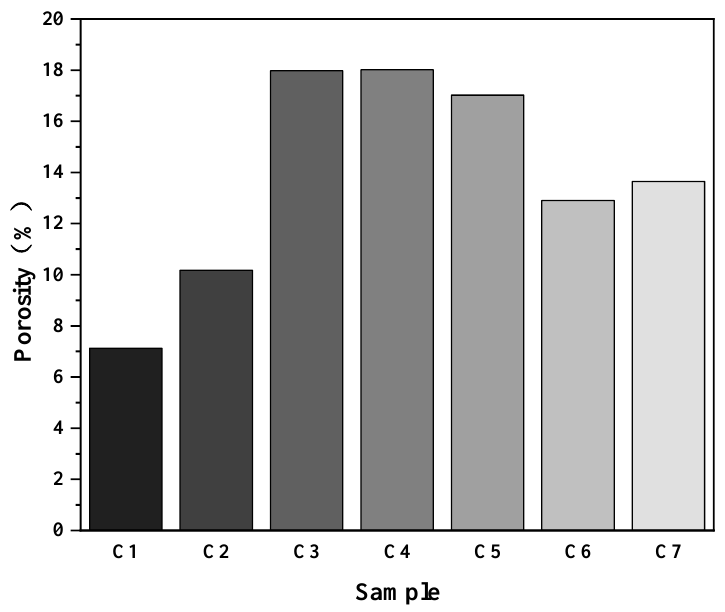
Figure 8. Porosity of each mix group.